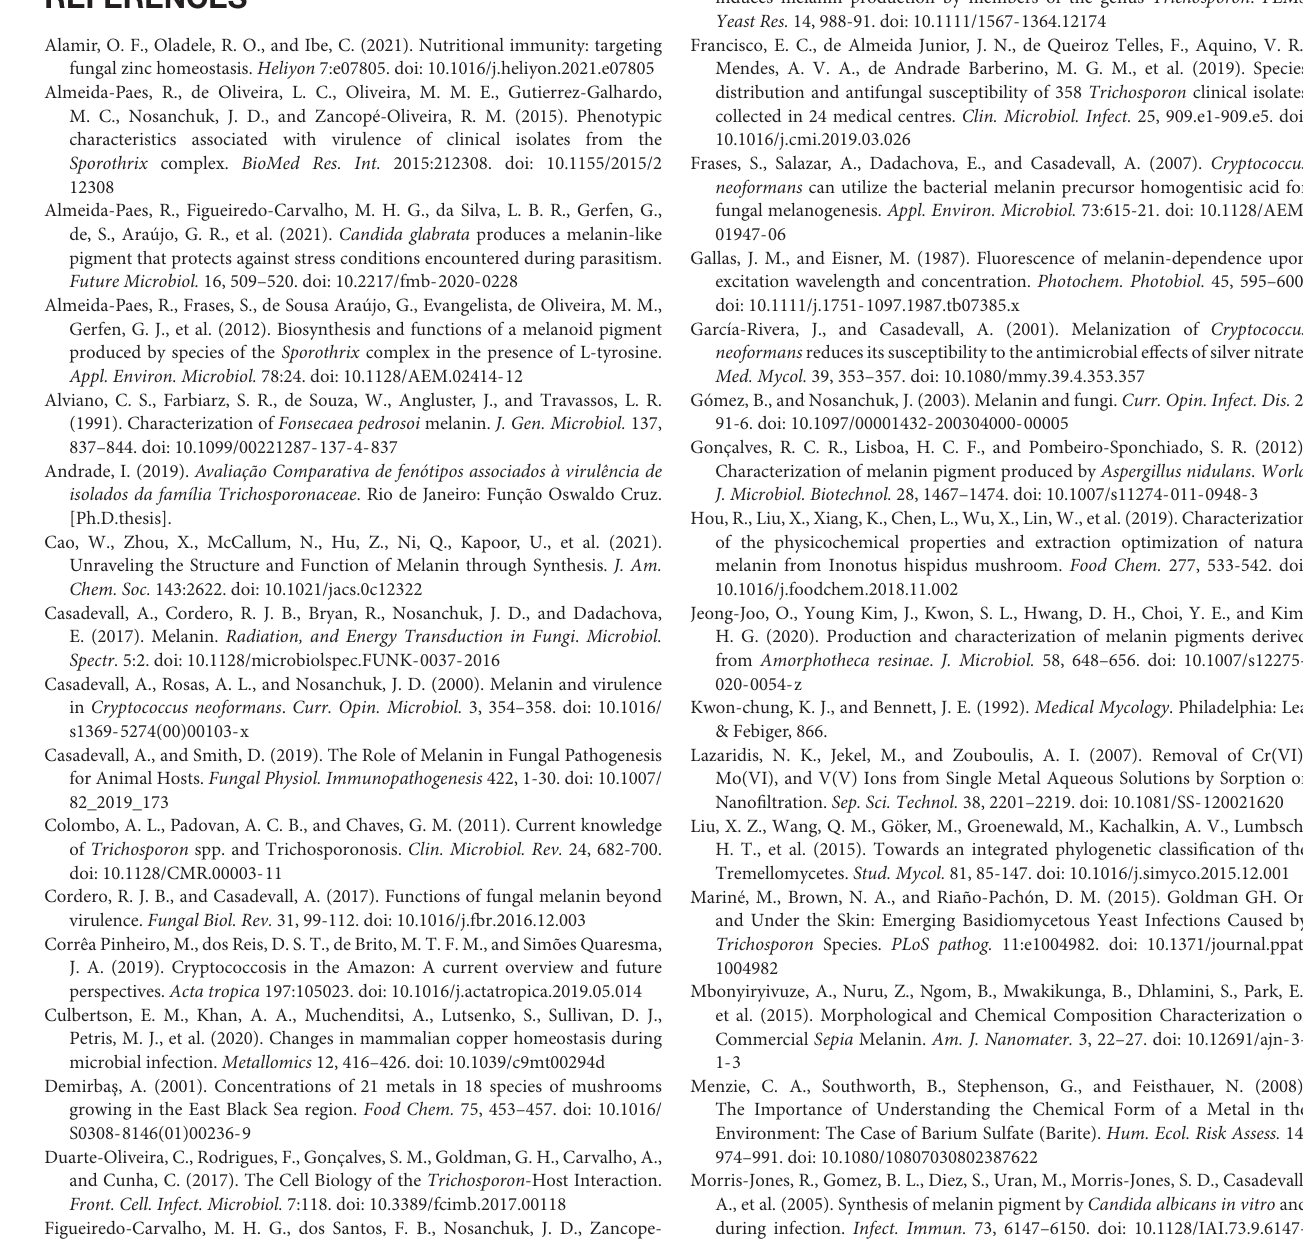
Figueiredo-Carvalho, M. H. G., dos Santos, F. B., Nosanchuk, J. D., Zancope- Oliveira, R. M., and Almeida-Paes, R. L. (2014).